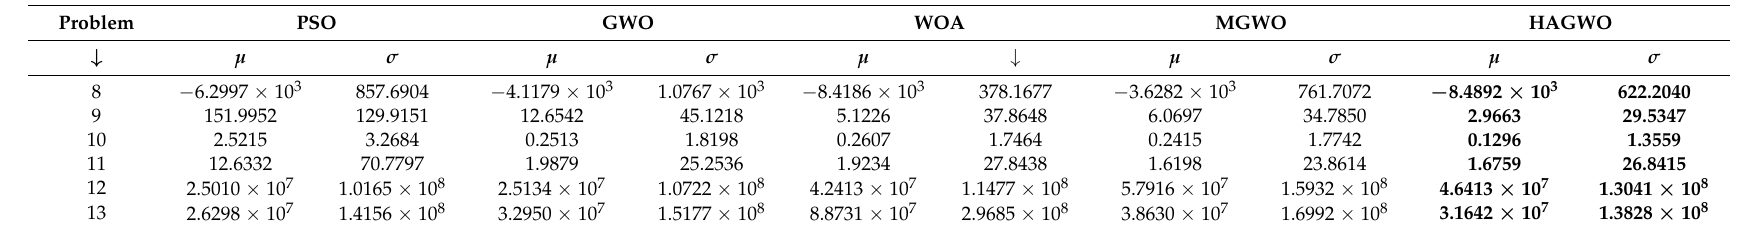
Table 7. Statistical results of multimodal benchmark functions.